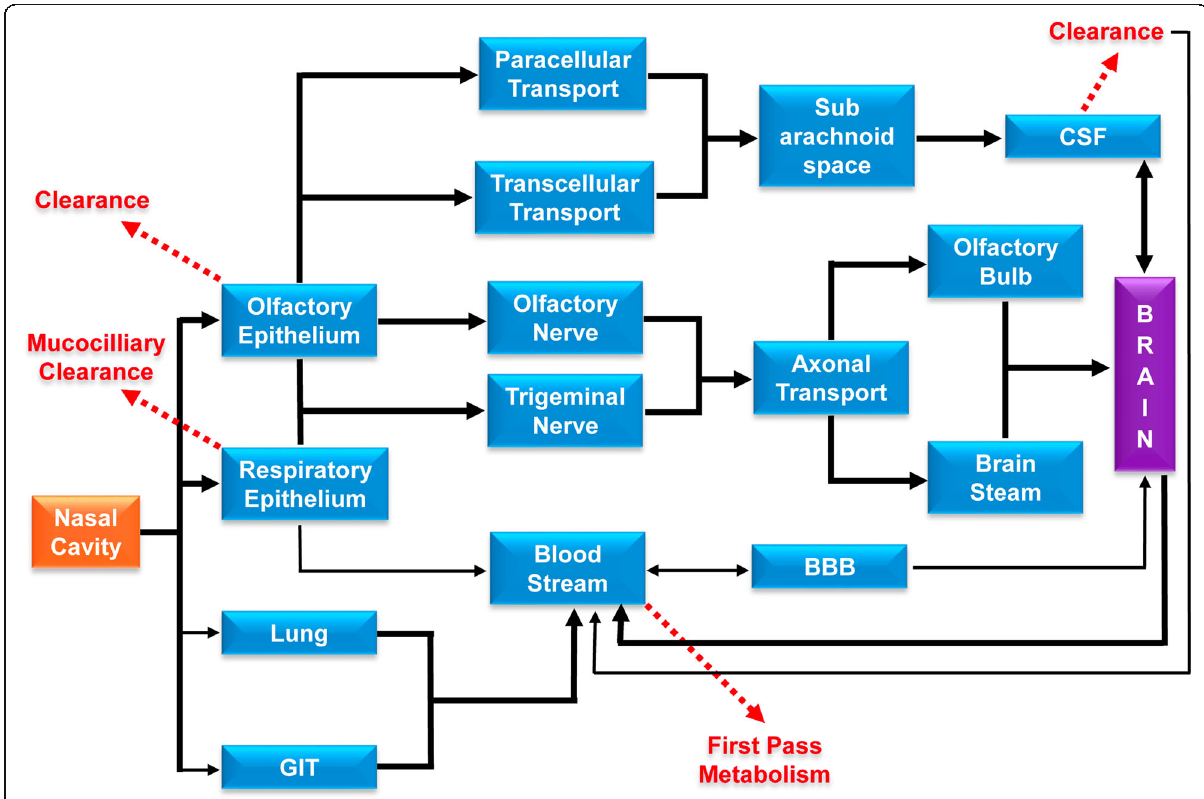
Fig. 3 Various nose to brain drug transport pathways. After nasal administration of drug, it can reach the brain via systemic, olfactory and trigeminal pathways based on drug absorption site/ time, physicochemical nature of the drug/ formulation and mode of application. The olfactory and trigeminal pathways can bypass first-pass metabolism of drug and BBB to deliver the drug inside the brain via paracellular/ transcellular routes of drug